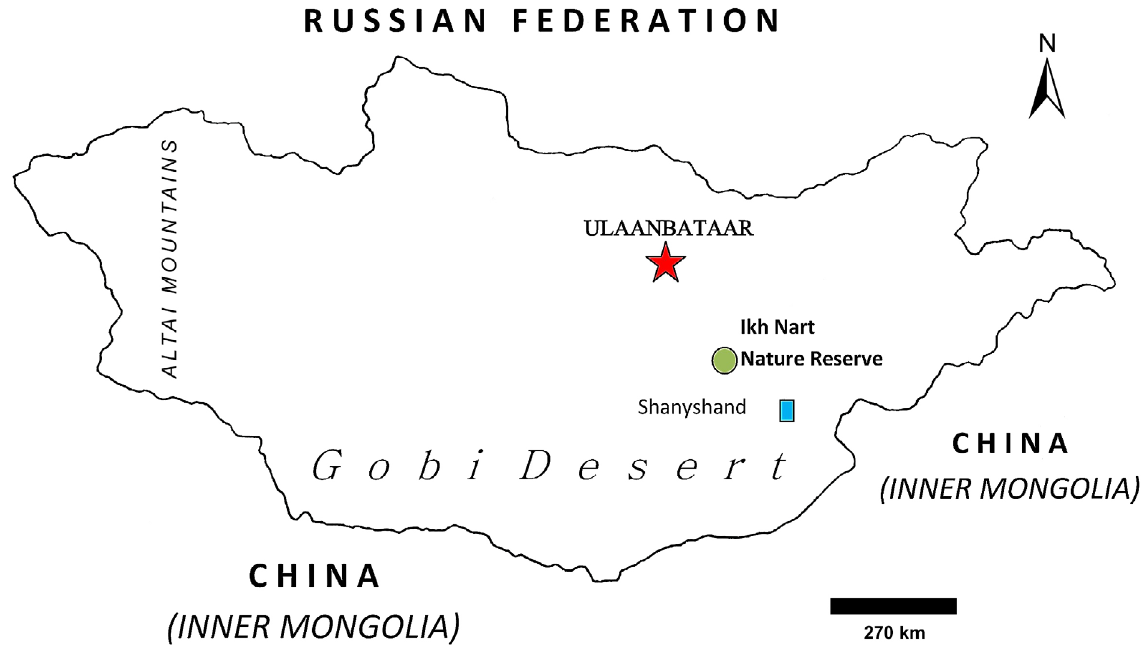
Figure 1. Outline of Mongolia showing location of Ikh Nart Nature Reserve between Ulaanbataar, the capital of Mongolia, and the city of Shanyshand to the south. Major geomorphic provinces of the Gobi Desert and Altai Mountains are shown